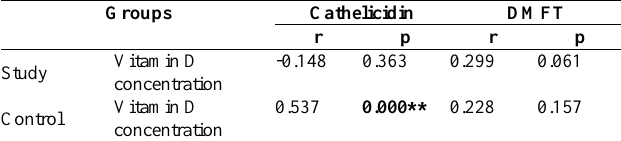
Table4: Correlation coefficients between serum vitamin D concentration and salivary cathelicidin and DMFT in the study and control groups